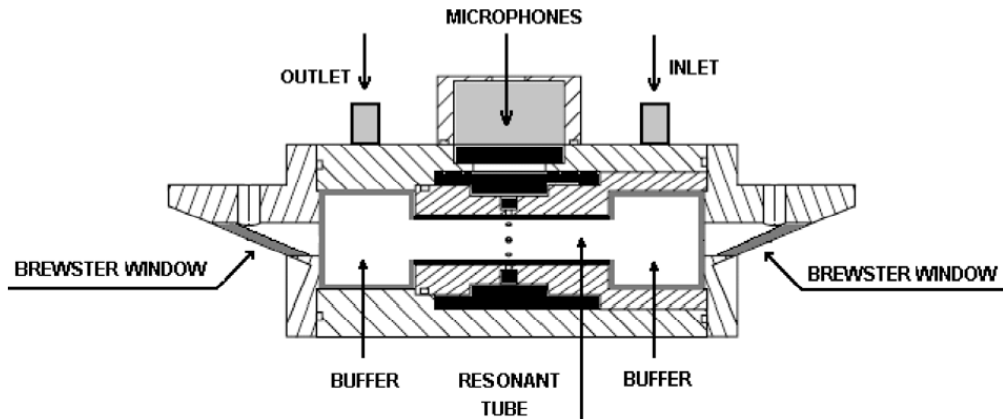
Figure 2. Diagram showing the design of the resonant photoacoustic cell